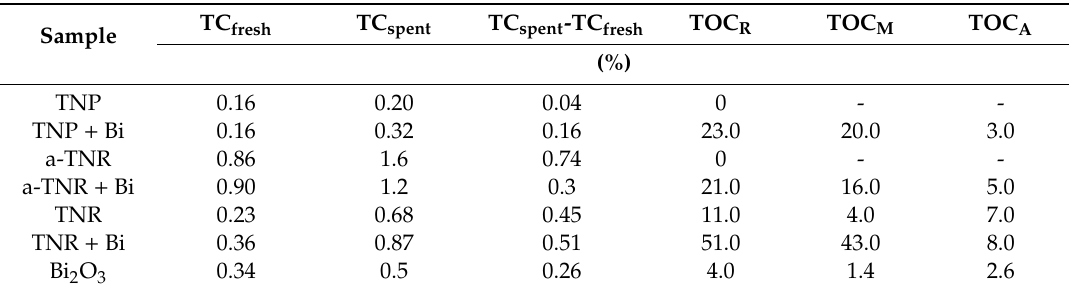
Table 3. The content of carbon accumulated on the surface of catalysts before (TC fresh ) and after (TC spent ) photocatalytic degradation of bisphenol A. TOC removal (TOC R ) represents a sum of TOC accumulation (TOC A ) and TOC mineralization (TOC M